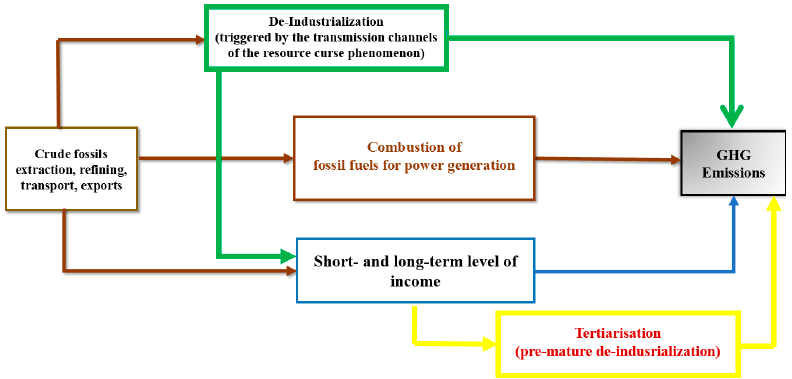
Figure 2. Determinants of the global greenhouse gases (GHGs) in Fossil ‐ Fuel ‐ Abundant